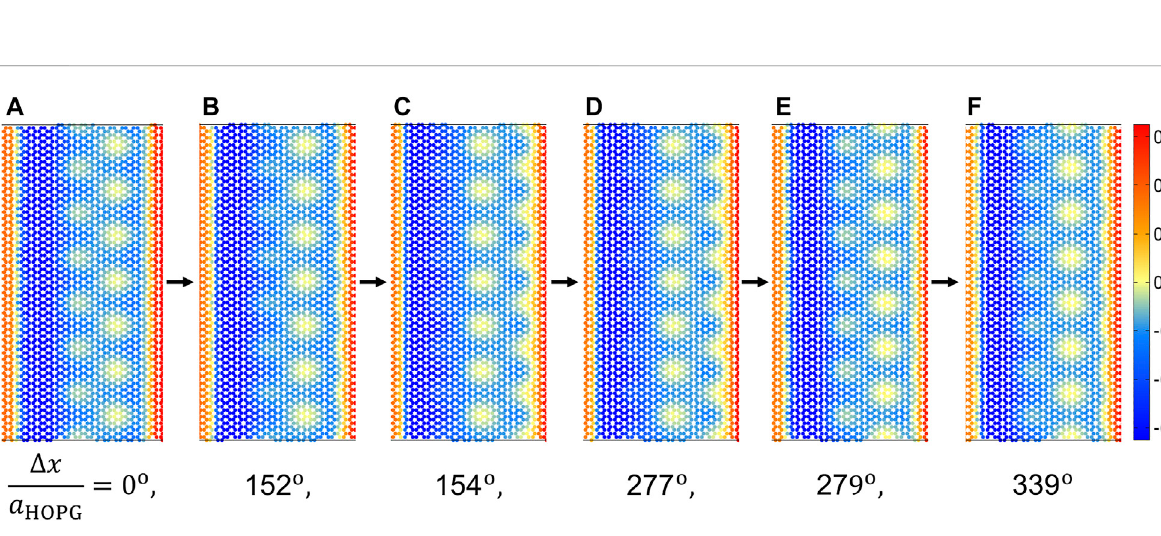
FIGURE 8 Normal displacements after different sliding distances, in units of Δ x / a HOPG : (A) 0, (B) 0.422, (C) 0.428, (D) 0.769, (E) 0.775, and (F)